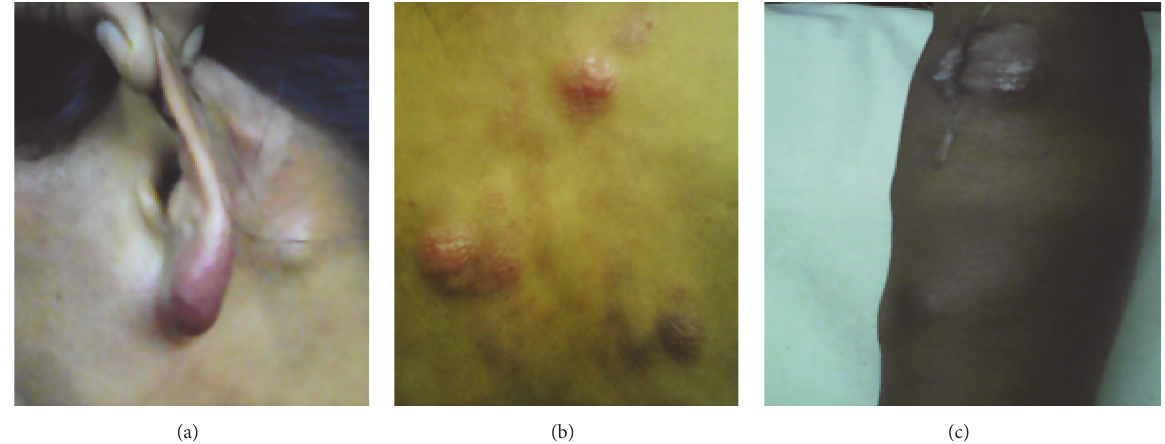
Figure 1: Images of the ear, back, and forearm showing multiple erythematous papular and nodular lesions.